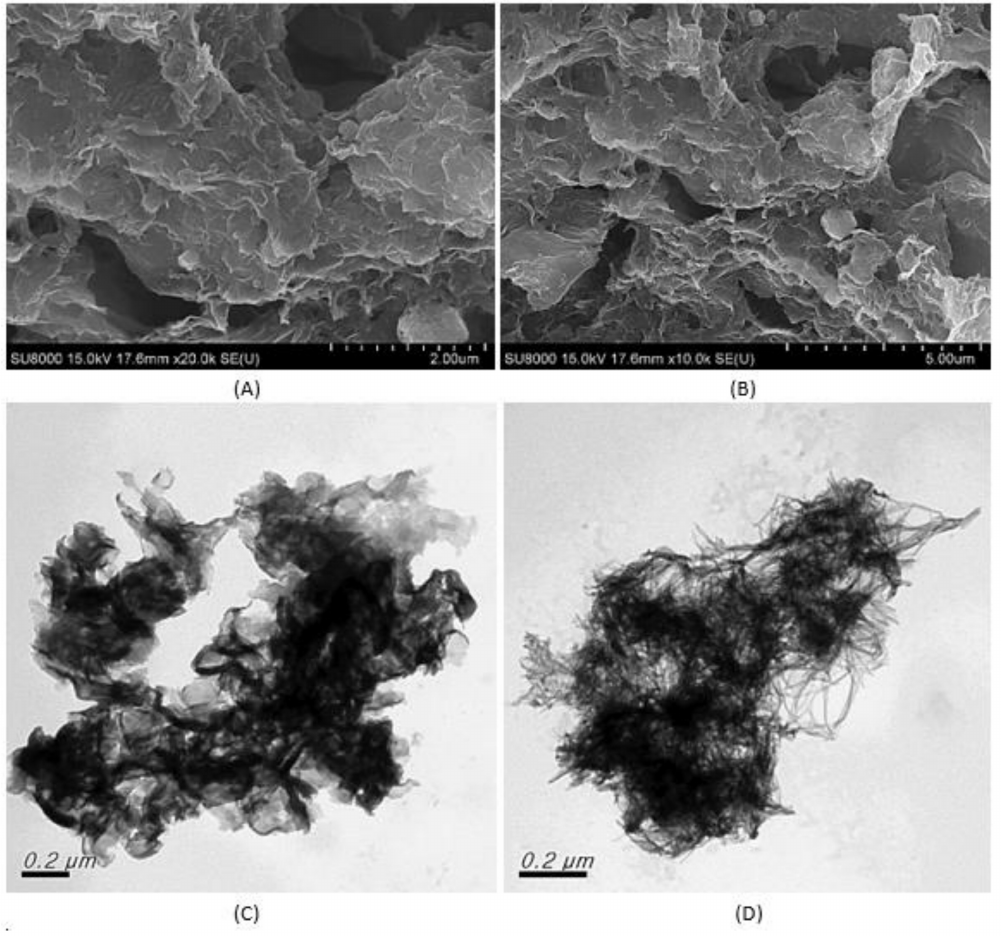
Figure 15. ( A , B ) SEM images and ( C , D ) TEM images of 3:1